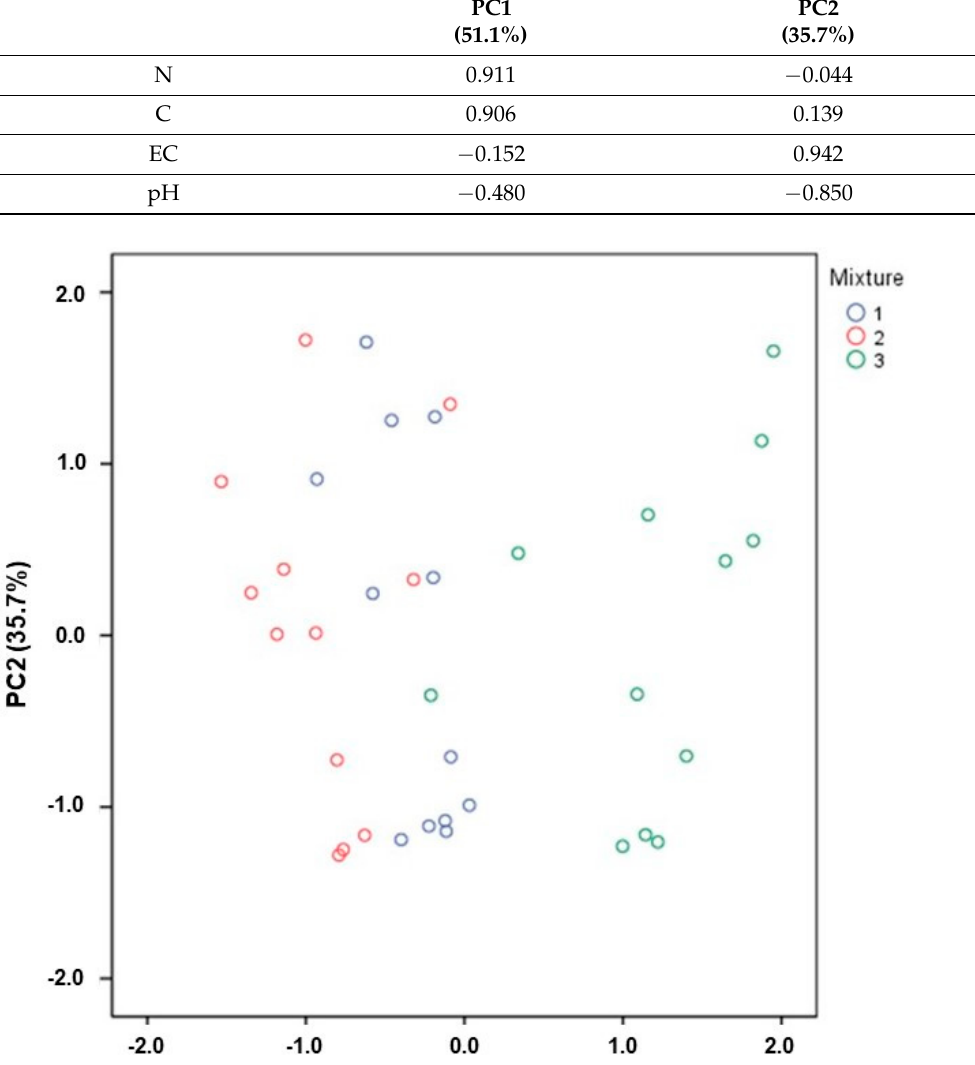
Table 4. Metal and microorganism content values at the end of the test and